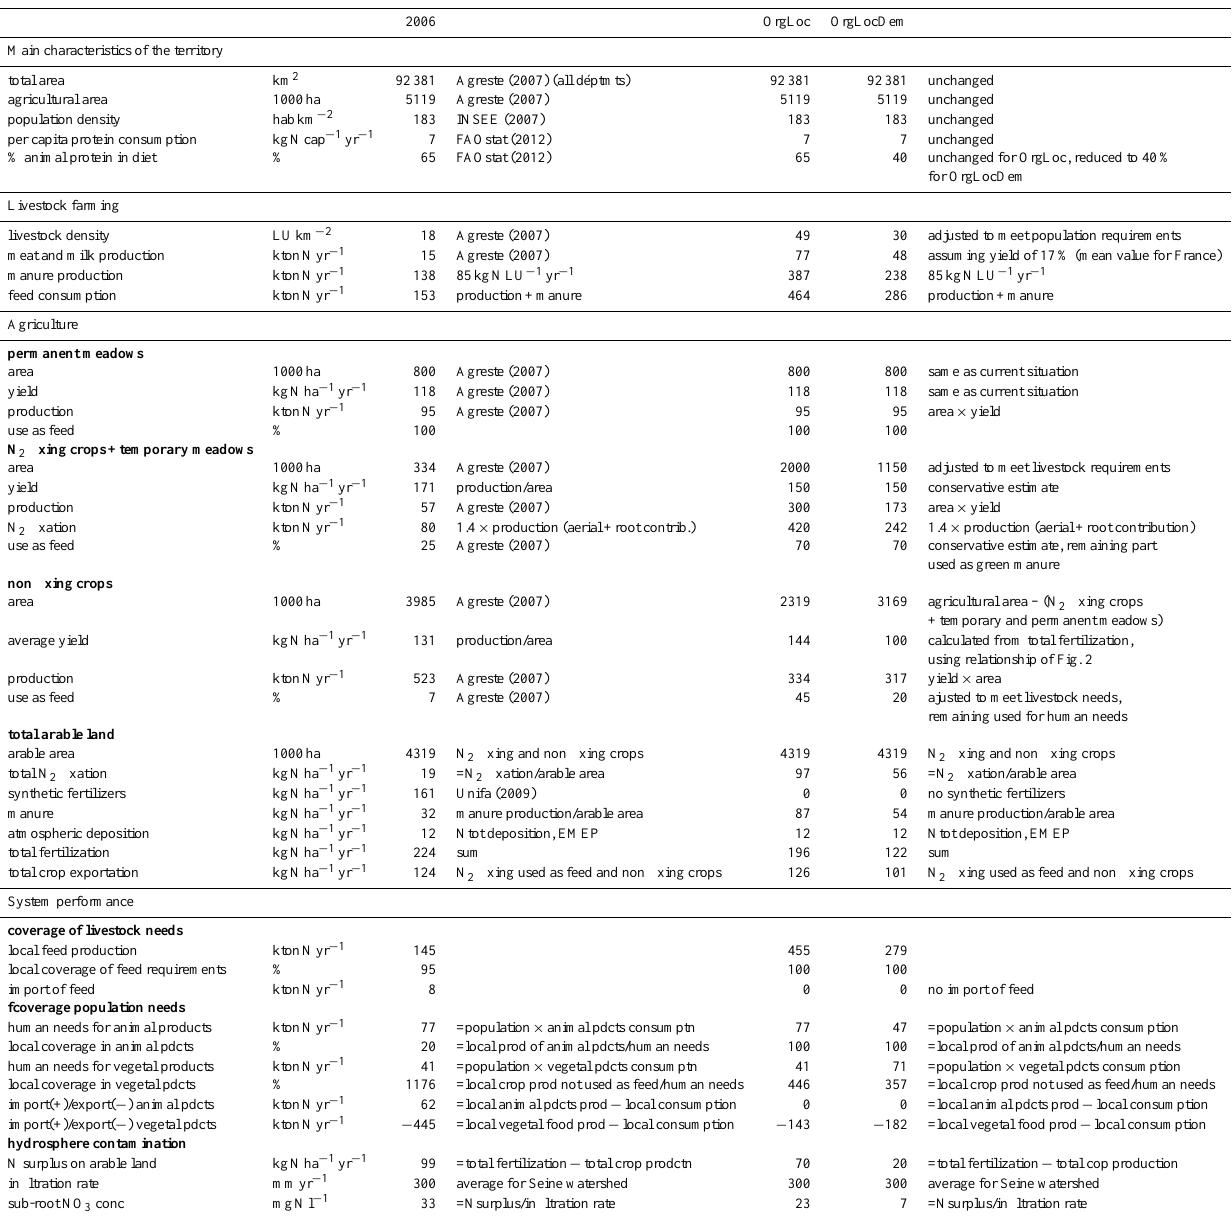
Table 1. Nitrogen budget of the agricultural system of the Seine watershed for the current situation (2006) and the organic and local (OrgLoc) and organic, local and demitarian (OrgLocDem) scenarios. The 2006 situation is primarily based on agricultural statistics (Agreste, 2007), with a few items calculated as explained in the text and summarised in the “remarks” column. The OrgLoc and OrgLocDem scenarios are calculated starting from the current situation and reallocating land use and livestock numbers in order to meet the following constraints: no use of synthetic fertilisers (organic fertilisation only), no import of feed (self-sufficiency in animal nutrition), no import of animal products (self-sufficiency in supplying animal products for local human consumption). Cereal production is calculated from the yield/fertilisation rela- tionship observed for the Seine basin d´epartements in the current situation. Cereal production in excess of livestock and human requirements is exported. Nitrate concentration in infiltrating sub-root water is estimated from the difference between fertilisation and yield in arable land, taking into account an infiltration rate of 300mmyr − 1